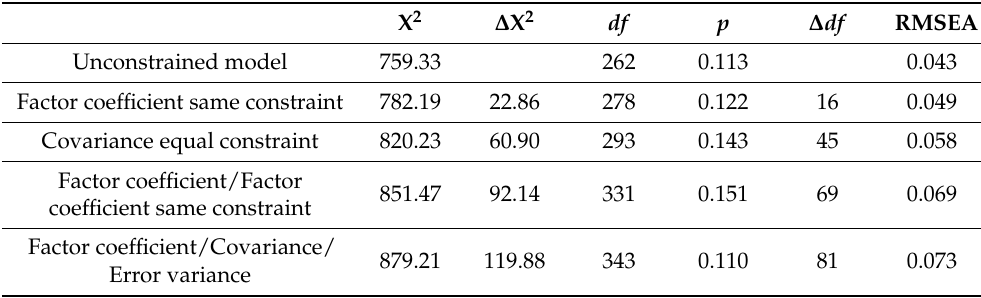
Table 16. Results of the Verification of Measurement Equivalence by